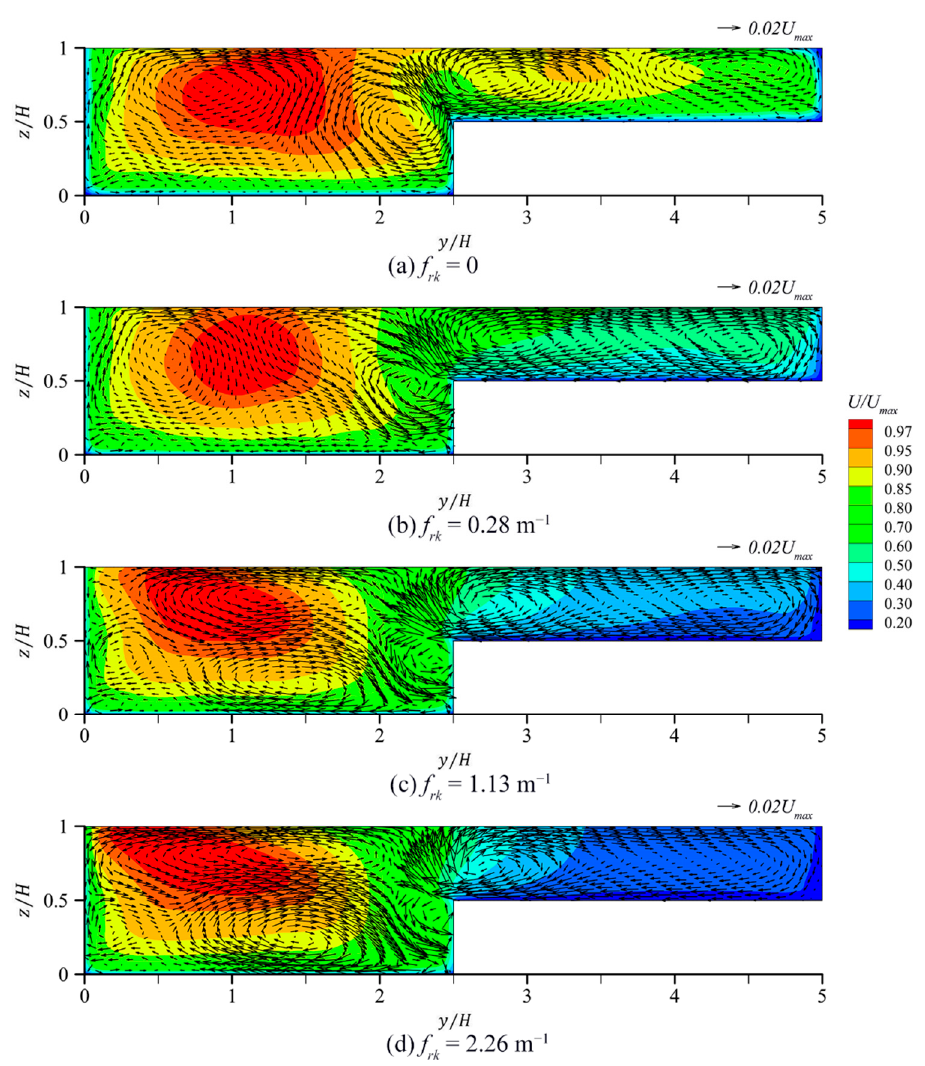
Figure 7. Sectional distribution of streamwise velocity U and secondary currents ( V , W ) with different floodplain vegetation densities. (a) Case with f rk =0. (b) Case with f rk =0.28m − 1 . (c) Case with floodplain vegetation densities. ( a ) Case with f rk = 0. ( b ) Case with f rk = 0.28 m − 1 . ( c ) Case with f rk =1.13m − 1 . (d) Case with f rk =2.26m − 1 . f rk = 1.13 m − 1 . ( d ) Case with f rk = 2.26 m − 1